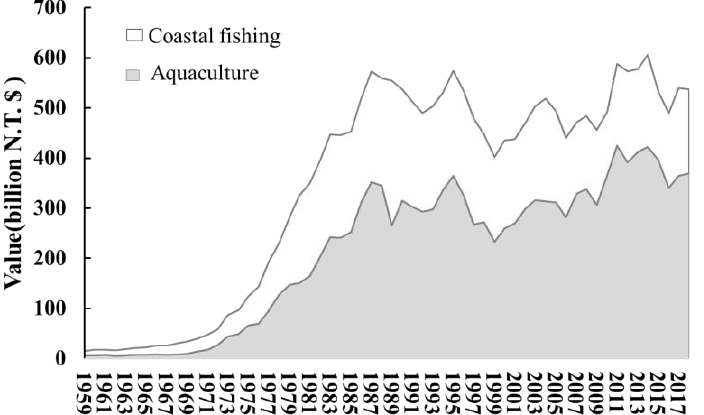
Figure 2. Coastal fishing and aquaculture production value in Taiwan, 1953–2018. The data were obtained from the Fishery Agency, accessed on 25 May 2021.